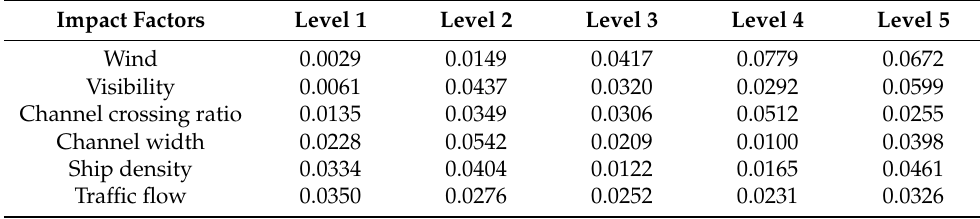
Table 5. The impact probability of navigational environment at different levels.